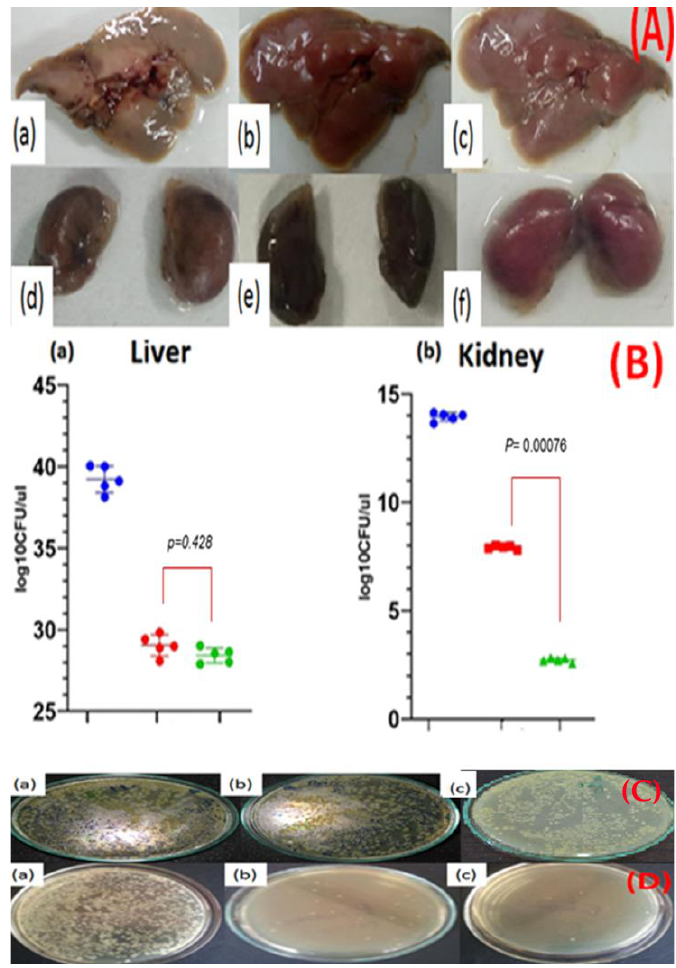
Figure 7. Effect of CIP (10 mg/Kg) and CIP-AuNPs (500 µg/Kg) on the colonization of E. faecalis in the ( A ) mouse organs — ( a ) infected liver, ( b ) CIP-treated liver, ( c ) CIP-AuNPs-treated liver, (d) infected kidney, (e) CIP-treated kidney, (f) CIP-AuNPs treated kidneys,infected kidneys, (B (a,b)) CFU E. faecalis in the infected liver and kidney; (C) CFU counting in the liver — ( a ) infected, ( b ) CIP-treated, and ( c ) CIP-AuNPs-treated; ( D ) CFU counting in the kidneys — ( a ) infected, ( b ) CIP-treated, and ( c ) CIP-AuNPs-treated.